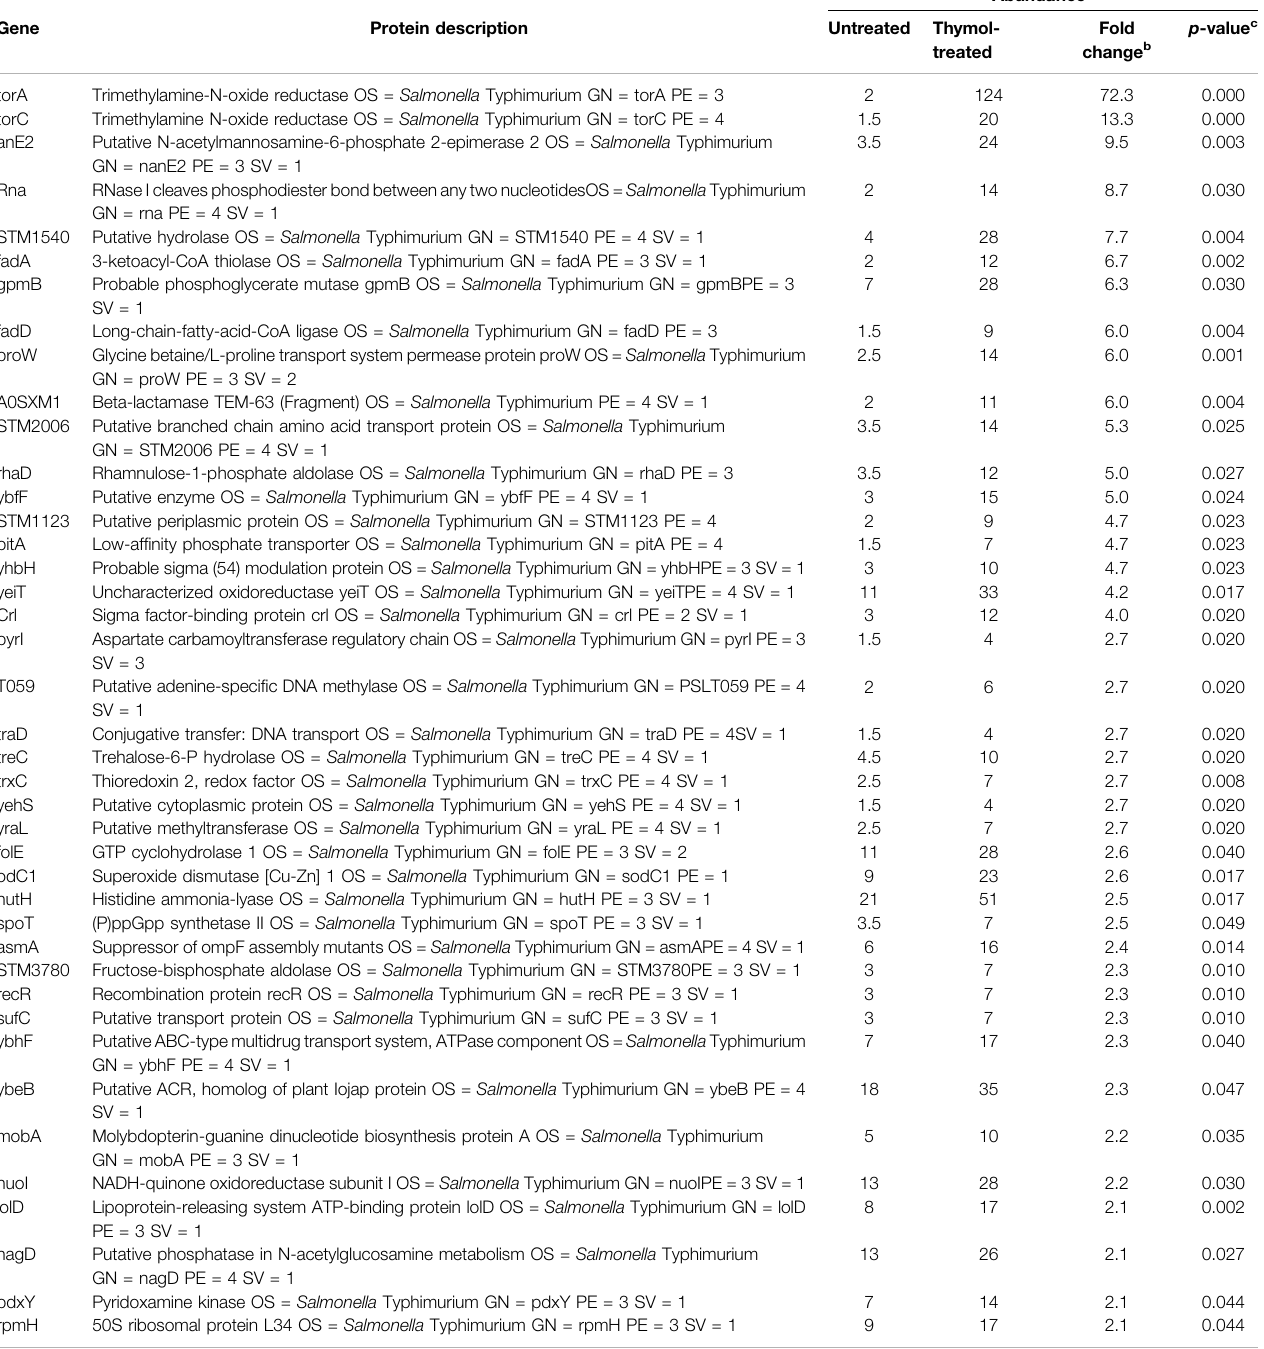
a Averaged spectral counts from three biological replicates. b Fold change in protein abundance; positive or negative values indicate higher or lower levels in the thymol-treated samples comparing to untreated cells. c p -values were calculated using paired Student ’ s t